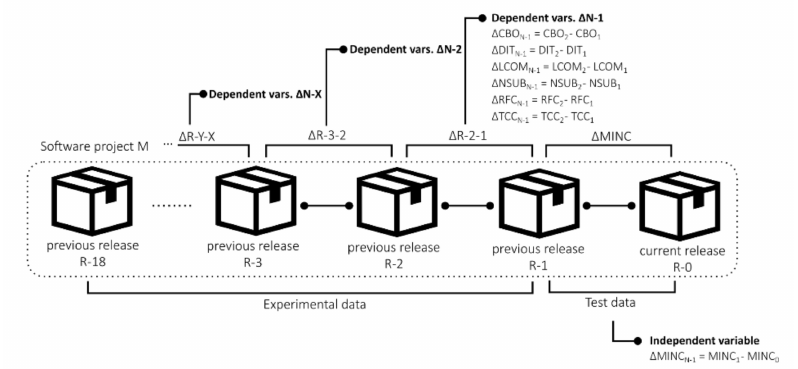
Figure 4. The process of calculation of changes in software metric measurement values.